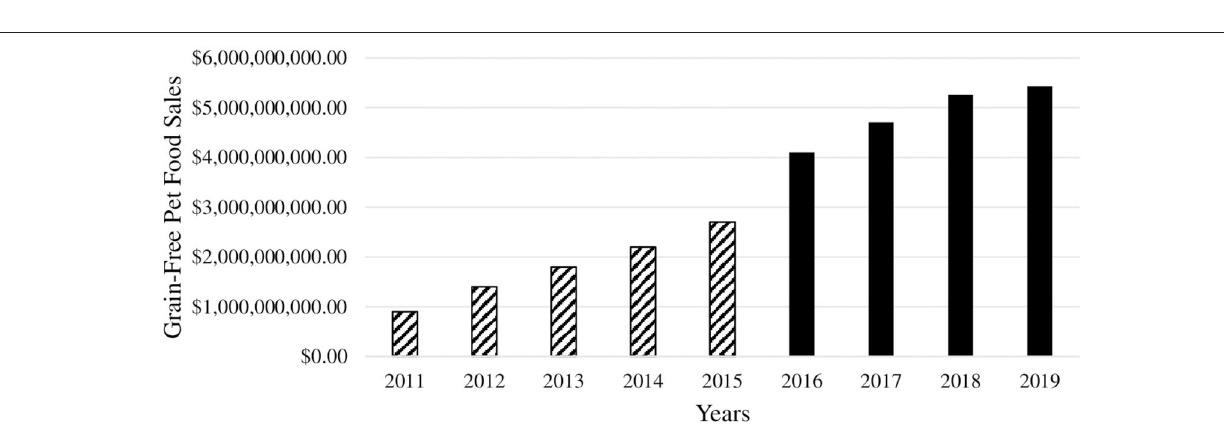
FIGURE 5 | Grain-free pet food sales for the past 10 years. Stripe bars: Years 2011–2015, denotes grain-free pet food sales through pet specialty retail stores only. Solid bars: Years 2016–2019 denotes sales through brick-and-mortar food, drug, mass, and convenience stores in addition to pet specialty stores. Grain-free sales through farm and feed stores, veterinary clinics, electronic commerce, and any privately-owned stores selling pet food are excluded. Data provided by the Nielsen Company and used with